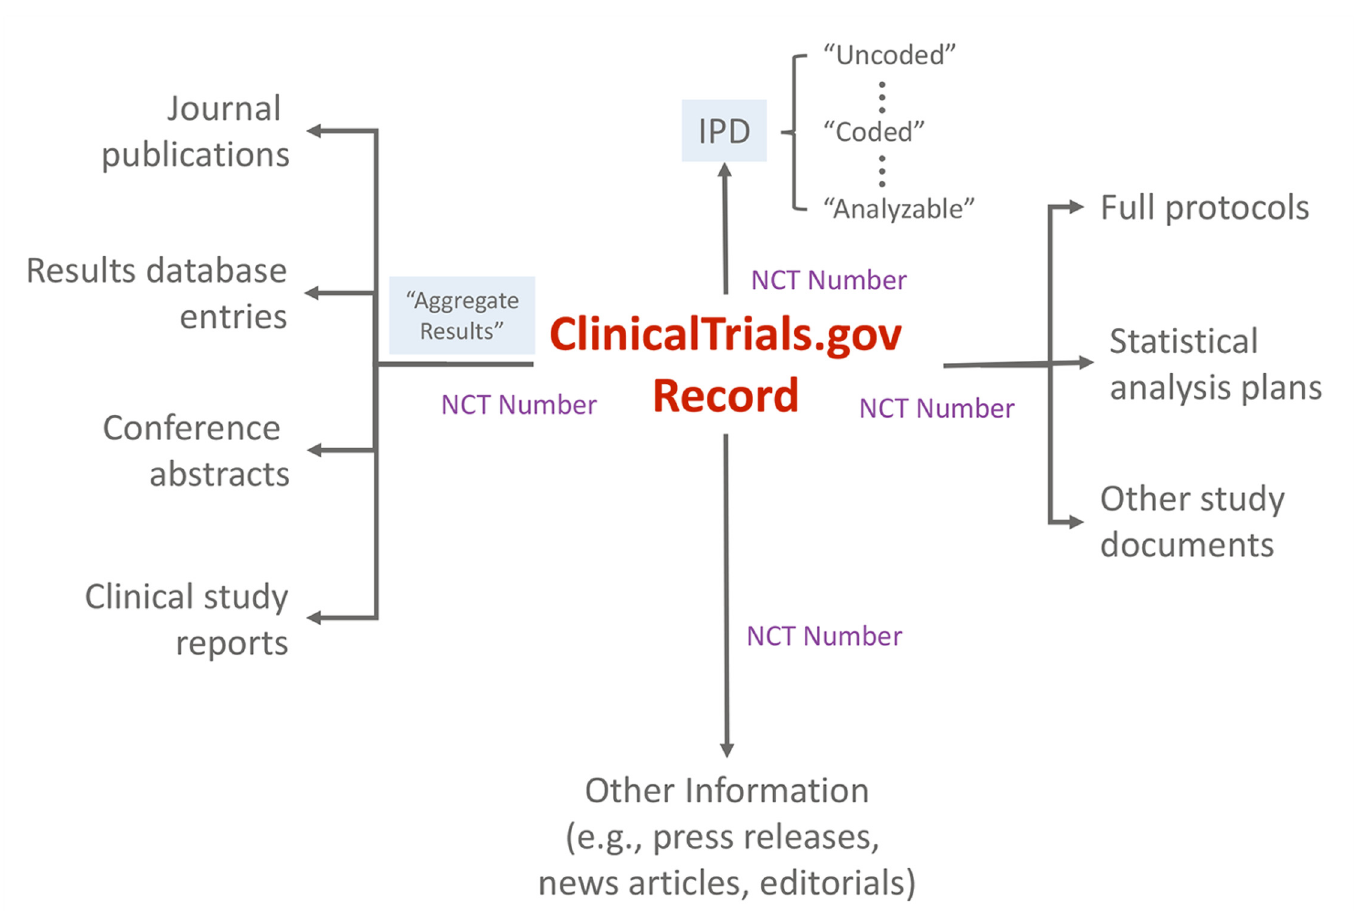
Fig 3. Schematic depicting ClinicalTrials.gov as an “ information scaffold ” using the record unique identifier (NCT number) to link to various online